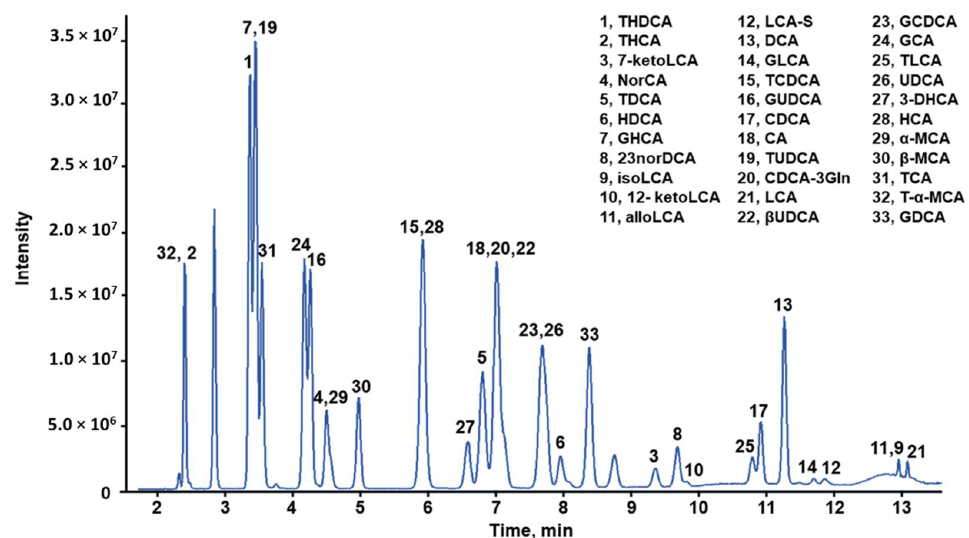
Figure 2. Chromatogram of 33 BAs/BA salts produced by ultrahigh-performance liquid chromatography coupled to tandem mass spectrometry (UHPLC–MS/MS). The sample concentration was 100 ng/mL. Abbreviations are listed in Table 1.